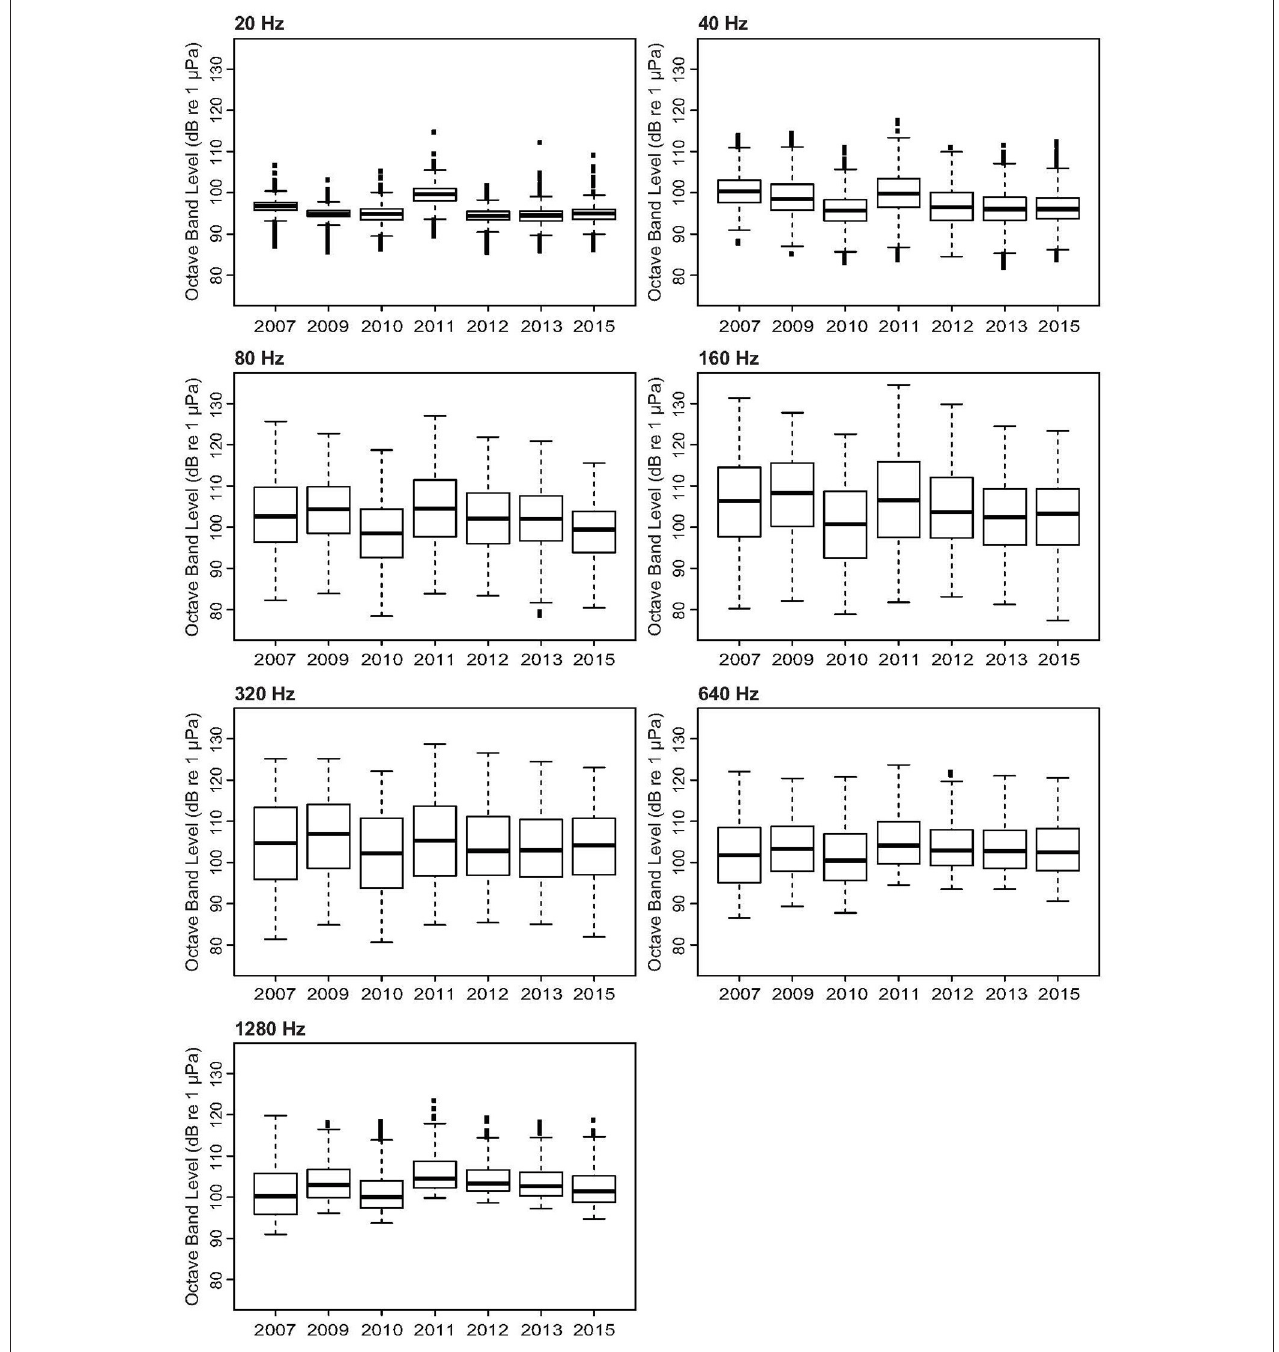
FIGURE 11 | Variation in selected octave-band noise levels across the 9-year period considered in the temporal analysis of Mosman Bay.